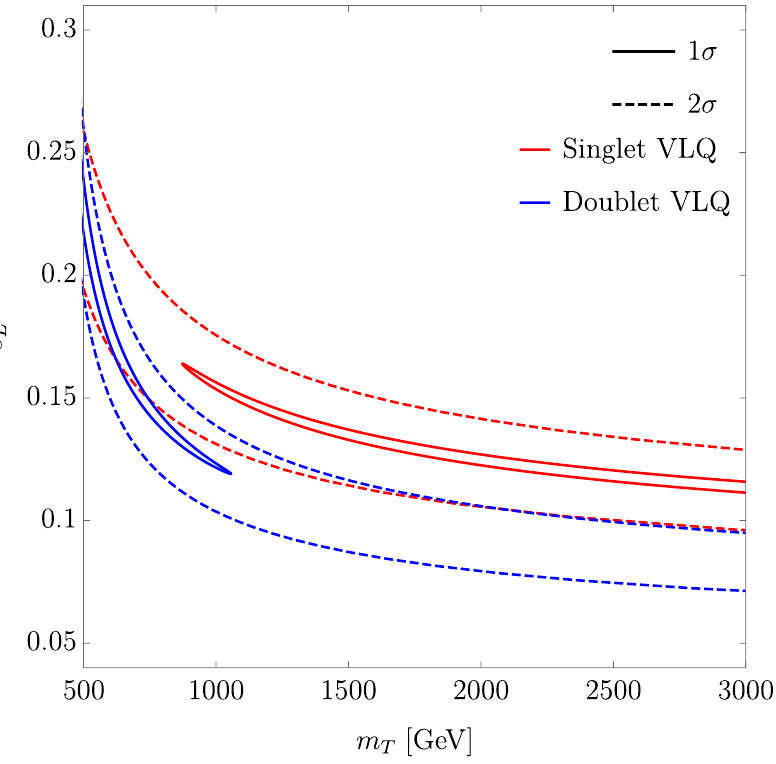
Figure 4 . The one (solid) and two (dashed) sigma CL contours for the singlet (red) and doublet (blue) partners where on the vertical axis we show the mixing-angle as a function of the vector-like (VLQ) quark mass, see text for more